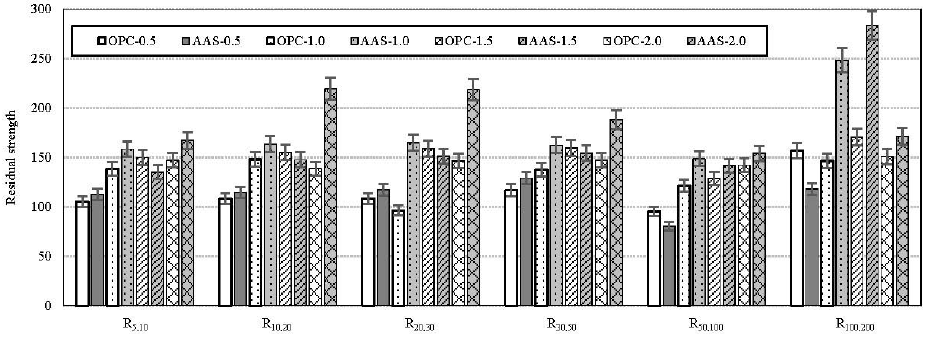
Figure 8. Comparison of residual strength factors.